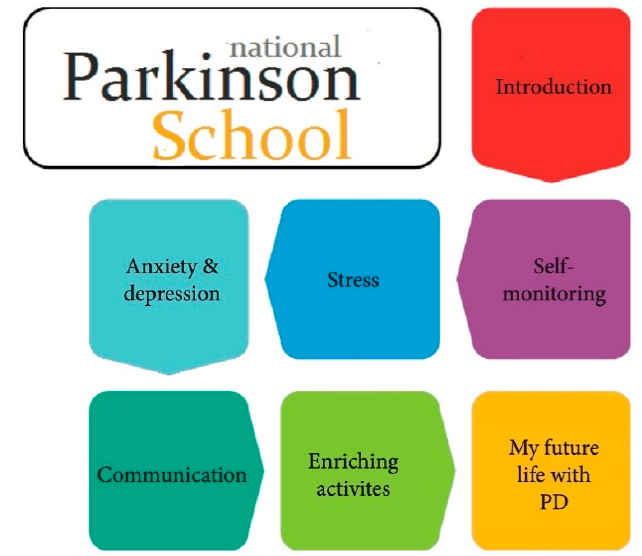
Figure 1. Modular elements of the Swedish National Parkinson School.